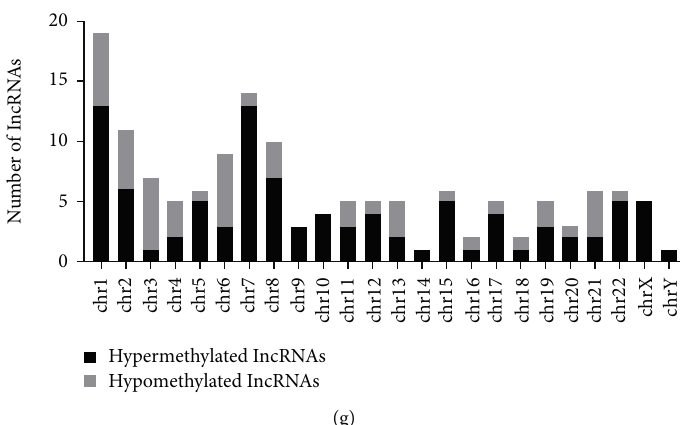
Figure 2: Overview of di ff erentially m6A-methylated lncRNAs and mRNAs in pPDLSCs with SMS. Hierarchical clustering results show di ff erentially m6A-methylated lncRNAs (a) and mRNAs (b). Cool colors represent low levels. Warm colors represent high levels. Positional relationship categories of the di ff erentially methylated lncRNAs (c), hypermethylated lncRNAs (d), and hypomethylated